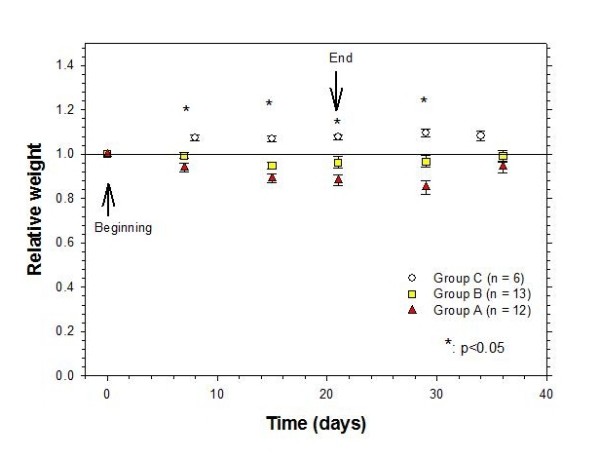
Evaluation of the loss weight change along time. Group A: cervical cancer xenografts treated with radiotherapy, cisplatin and gemcitabine; Group B: xenografts treated with radiotherapy and gemcitabine; Group C: untreated controls. Solid line signals a relative weight equal to 1, i.e. no change of weight. Values are given as means ± SEM.